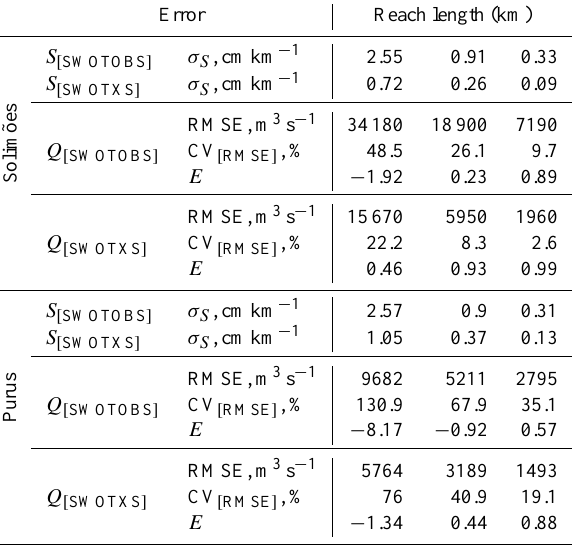
Table 2. Summary of along-channel variability in modelled water- surface slope and channel discharge at low and high